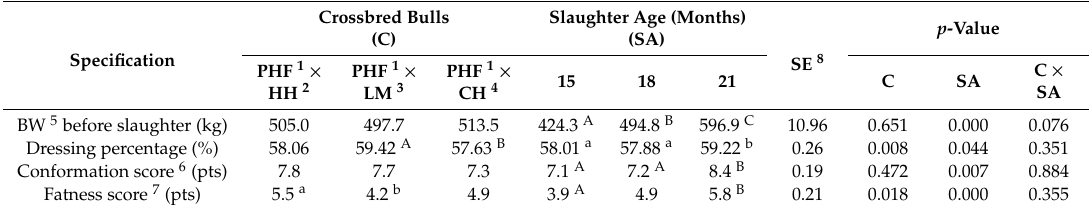
Table 3. E ff ects of genotype and slaughter age on carcass quality in crossbred